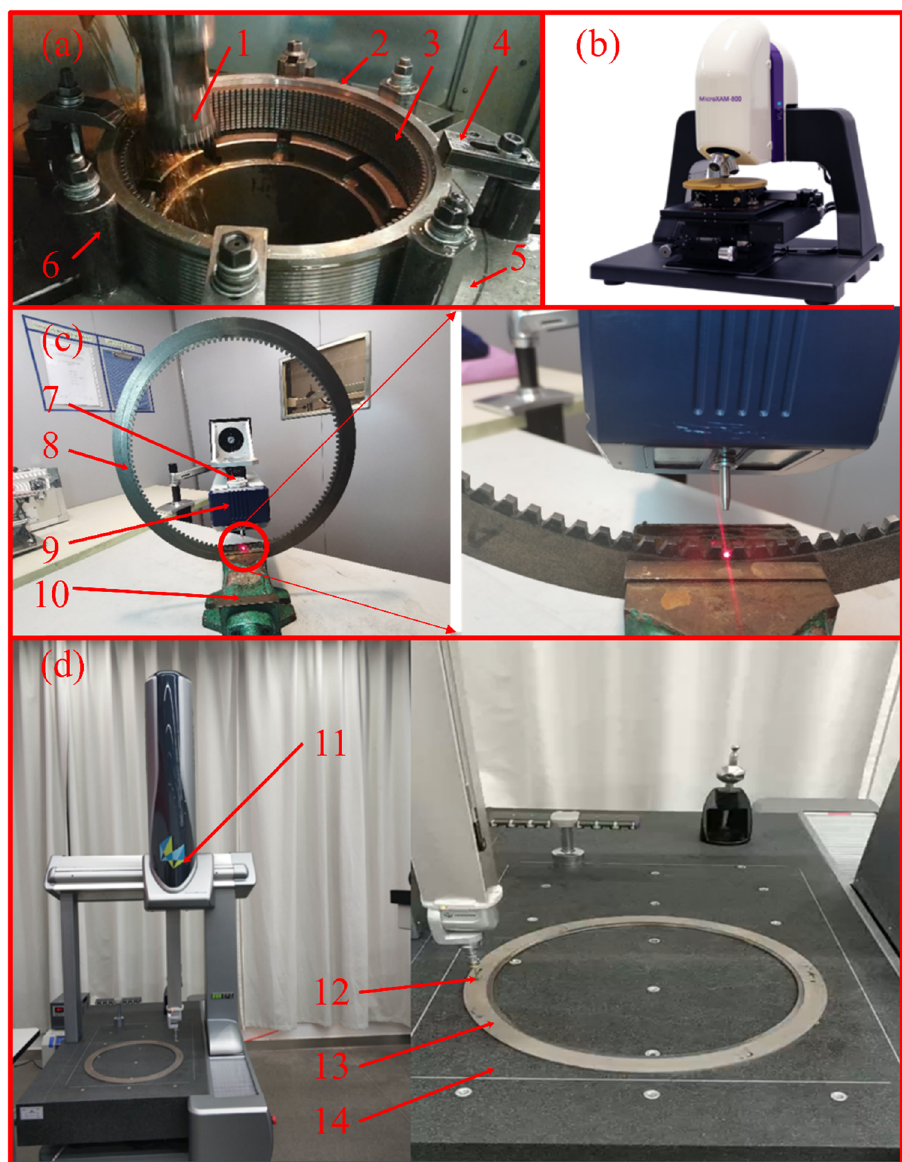
Figure 6: The experimental and detection equipment: ( a ) the worksite of gear shaping, ( b ) MicroXAM 3D optical pro fi ler, ( c ) the detection of residual stress, and ( d ) the detection of machining deformation ( 1, gear - shaping cutter; 2, annular pressing plate; 3, the friction disc to be machined; 4, the fi xture; 5, the rotary table of the gear - shaping machine; 6, concentric stop block; 7, level indicator; 8, the friction disc to be detected; 9, RS X - ray di ff ractometer; 10, tiger bench clamp; 11, coordinate measuring machine; 12, the probe; 13, the friction disc to be detected; 14, workbench )